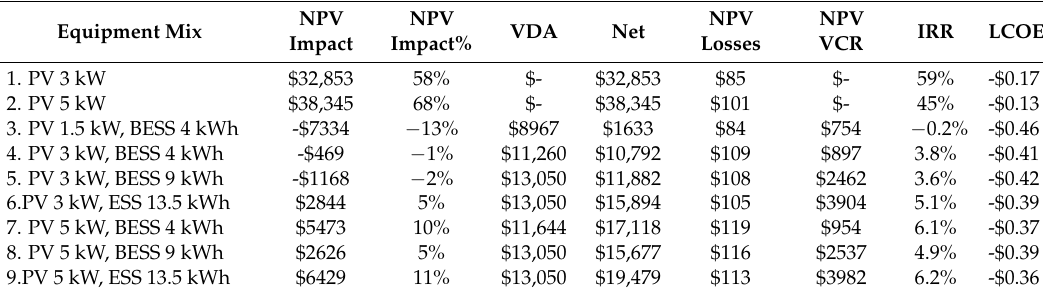
Table 10. Household financial results.